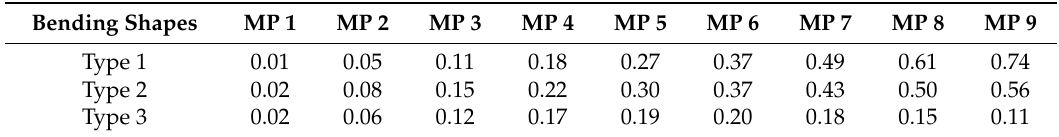
Table 6. The standard deviation of the displacement at each measuring point (MP) under different bending shapes. bending